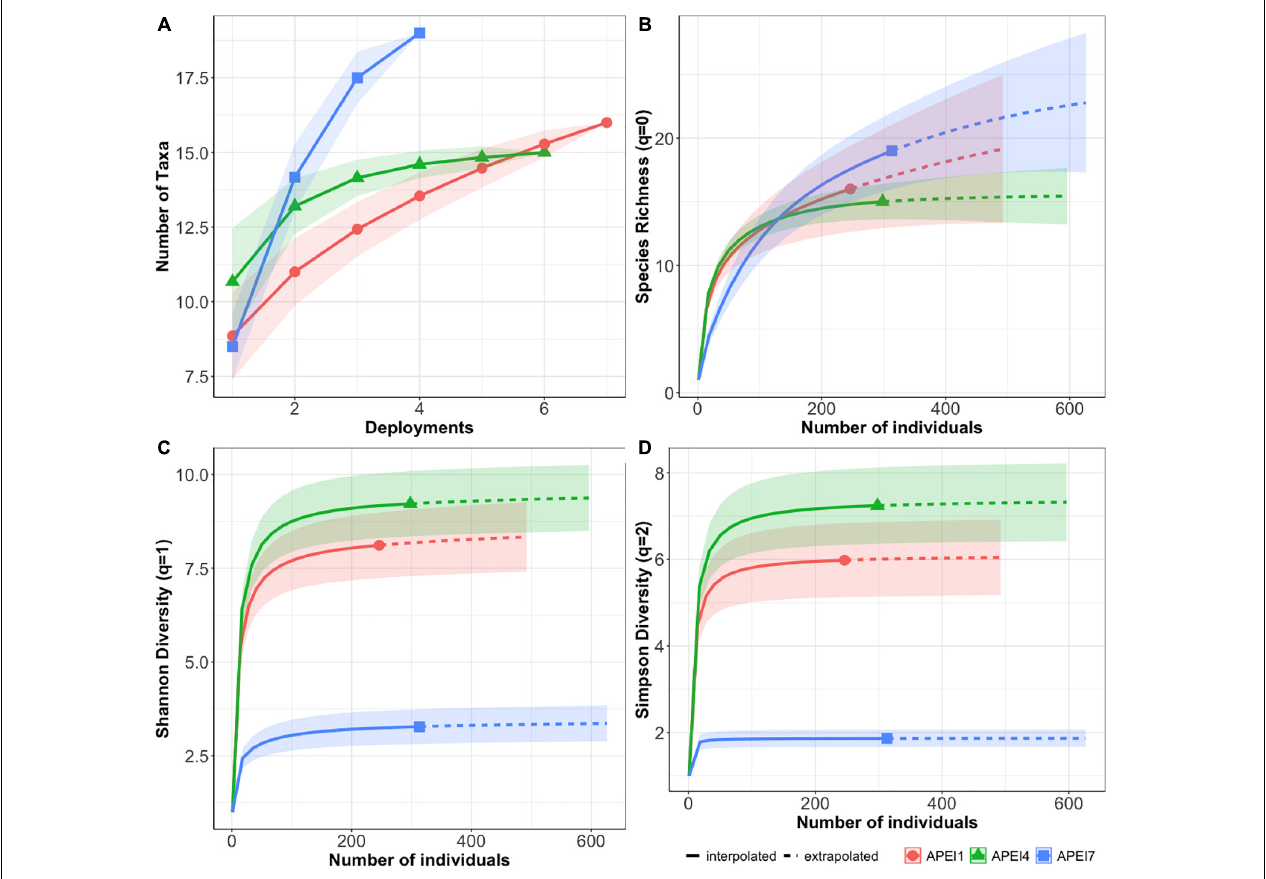
FIGURE 5 | Comparisons of sampling effort and diversity metrics between APEIs (red circle, APEI 1, green triangle APEI 4, blue square APEI 7). (A) Species accumulation curves for all APEIs. (B) Species richness (hill number q = 0), (C) Shannon diversity (Hill number q = 1) and (D) Simpson Diversity (Hill number q = 2) with 95% confidence intervals (shaded areas) for each APEI. For panel (B–D) interpolated values are shown with solid lines and extrapolated values with dashed